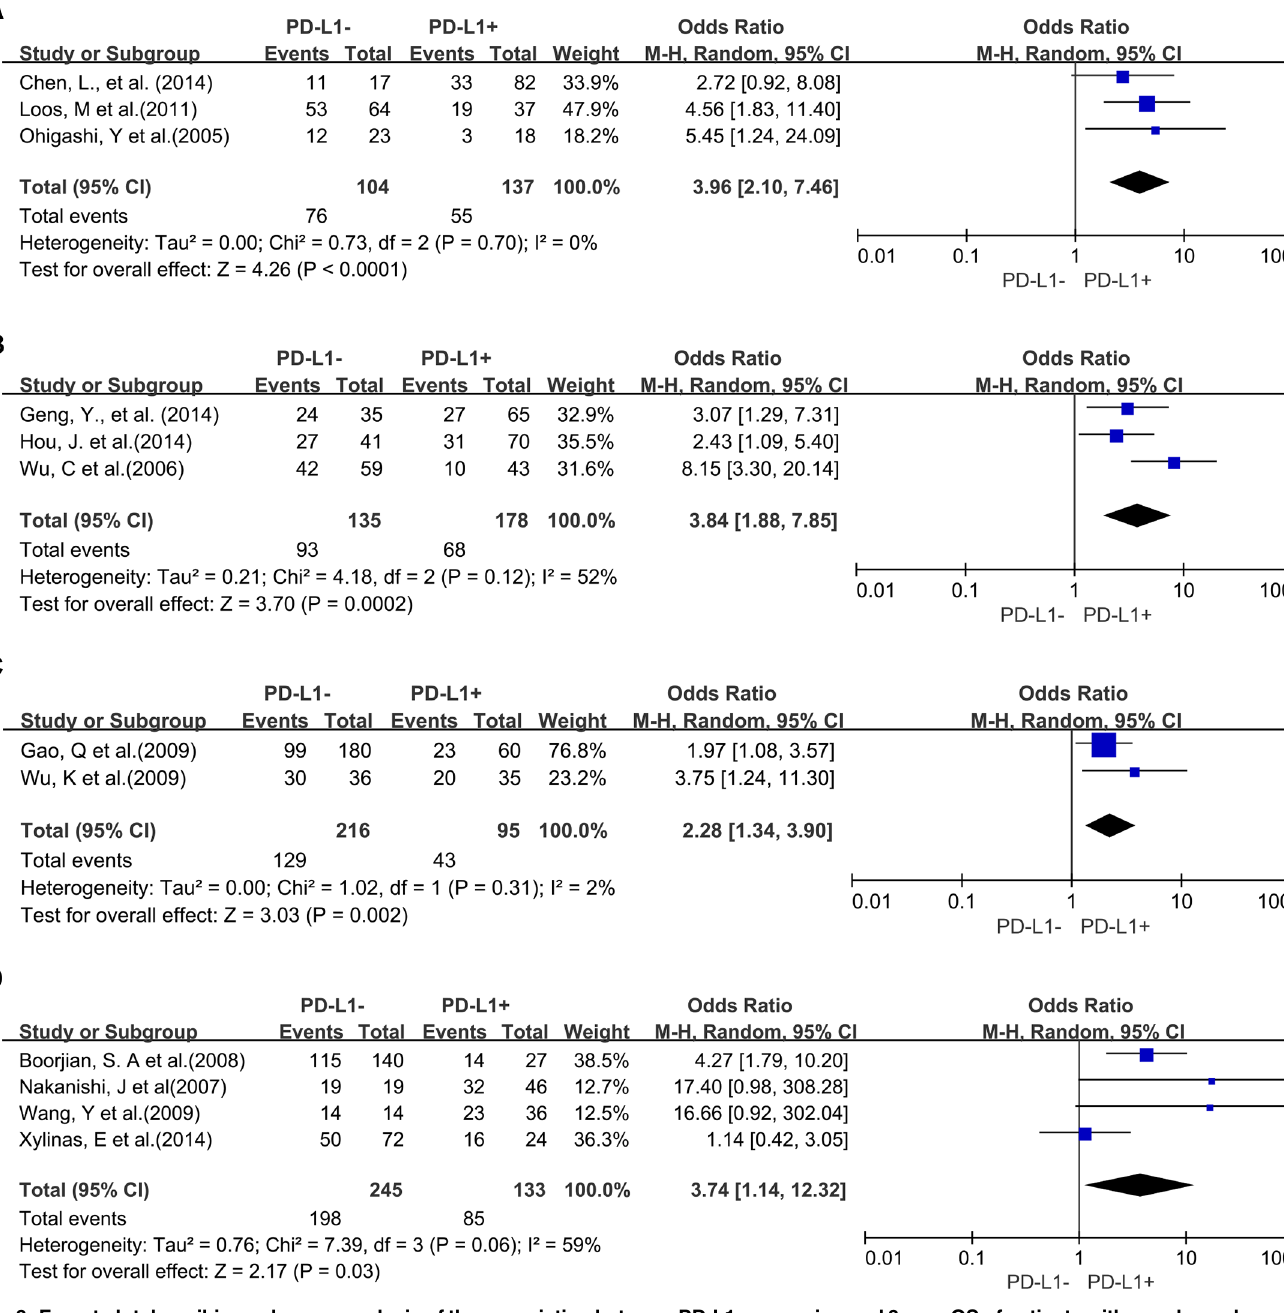
Fig 3. Forest plot describing subgroup analysis of the association between PD-L1 expression and 3-year OS of patients with esophageal cancer (A), gastric cancer (B), hepatocellular carcinoma (C) and urothelial cancer (D).